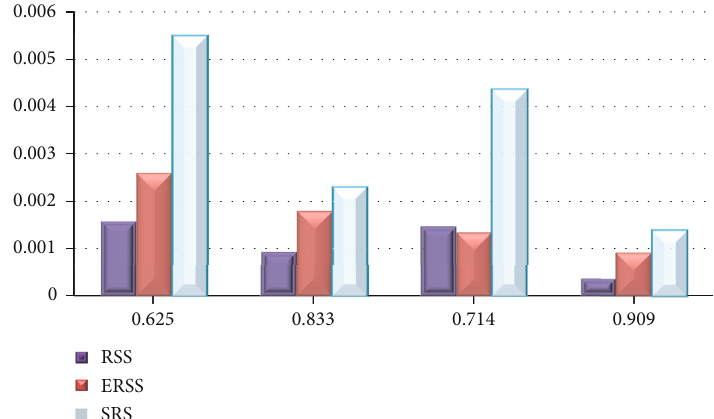
, m = ð 5, 5 Þ . 1 2 Þ